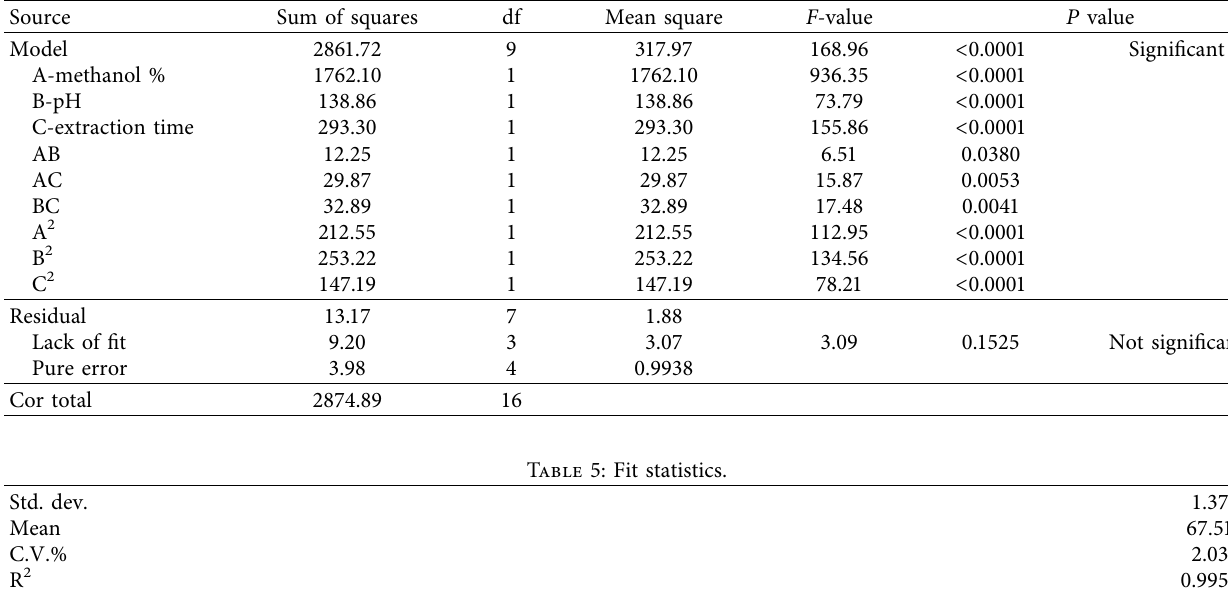
Table 4: ANOVA for quadratic model.